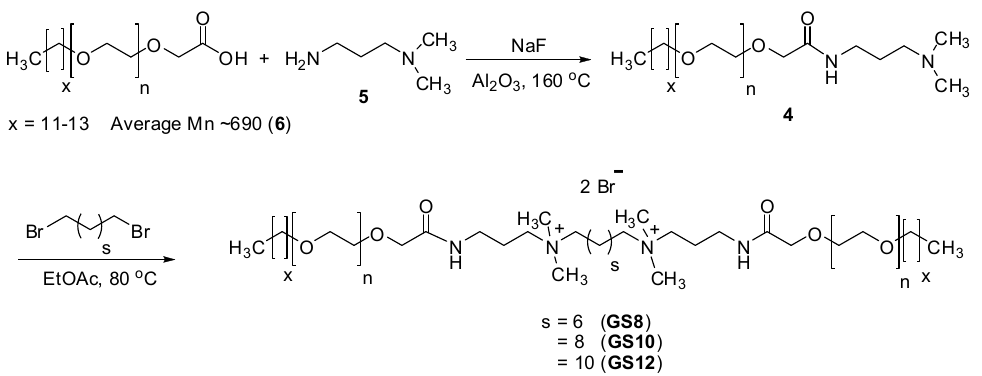
Figure 1. 1 H NMR of intermediate 4.